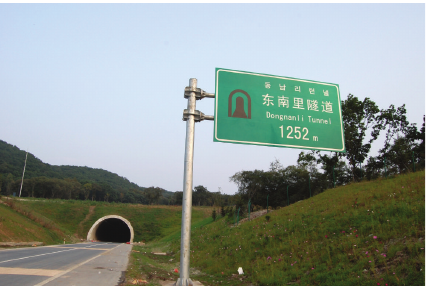
Figure 7: Dongnanli Tunnel.